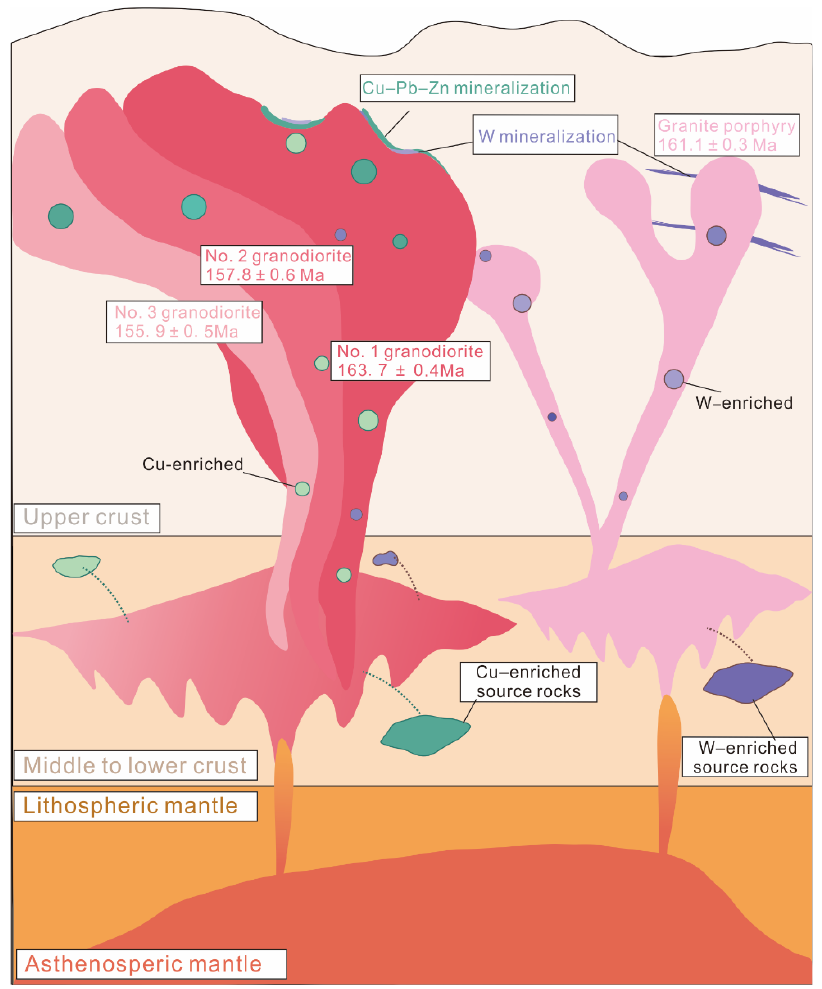
Figure 15. Schematic demonstrating multiple metallogenesis in the Tongshanling ore field: at ~163 Ma, amphibolite facies metamorphic basement partially melted to form I-type granodiorite magma, which reacted with carbonatite to form skarn Cu–Pb–Zn ore bodies. As the extension continued, magma was continuously pumped out of the cold storage, and No. 2 and No. 3 granodiorites (156~160 Ma) were formed in the late stage. Due to the magmatic activity at ~163 Ma, magmatic chambers were activated in a cold storage near the source area of granodiorite. After ~2 Ma, greater partial melting of the magmatic source region resulted in formation of granite porphyry (~161 Ma), and W ore bodies were formed when the exsolved hydrothermal fluid flowed through the felsic rock mass (such as granodiorite and